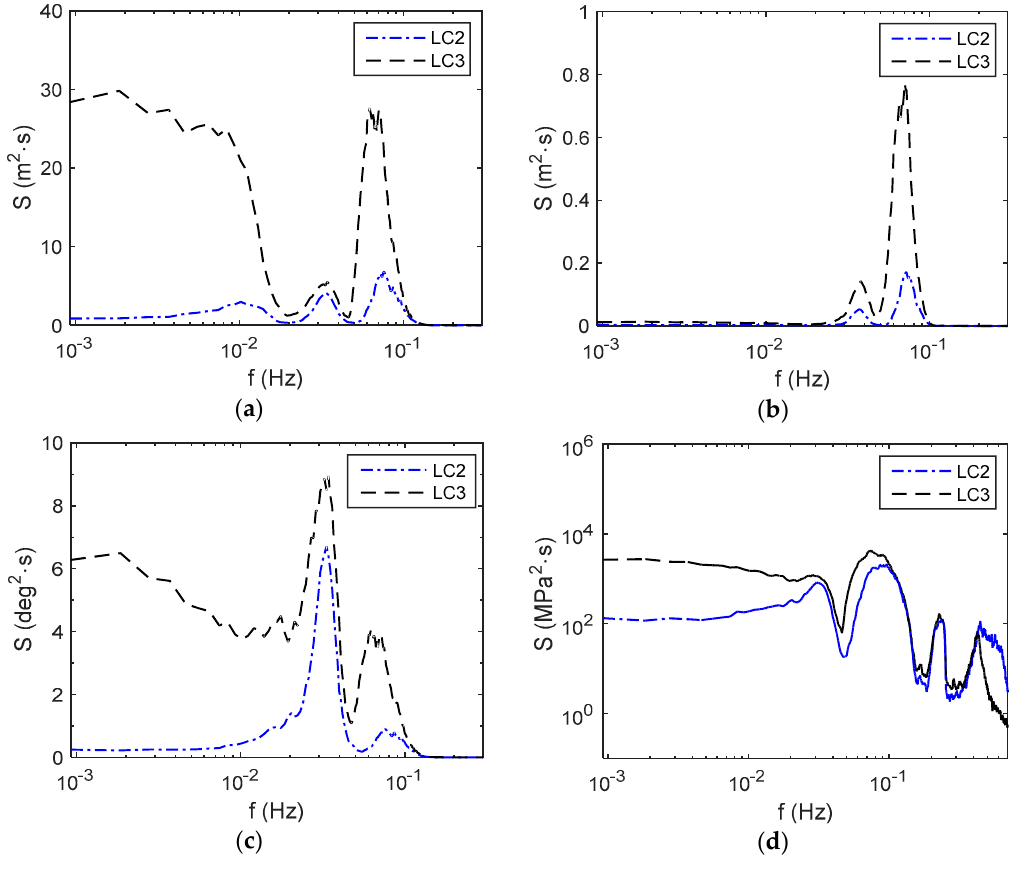
Figure 10. Response power spectra of foundation motions and tower base stresses of FOWT-SFFC under LC2 and LC3. ( a ) Surge motion spectrum; ( b ) heave motion spectrum; ( c ) pitch motion spectrum; ( d ) tower base stress spectrum.